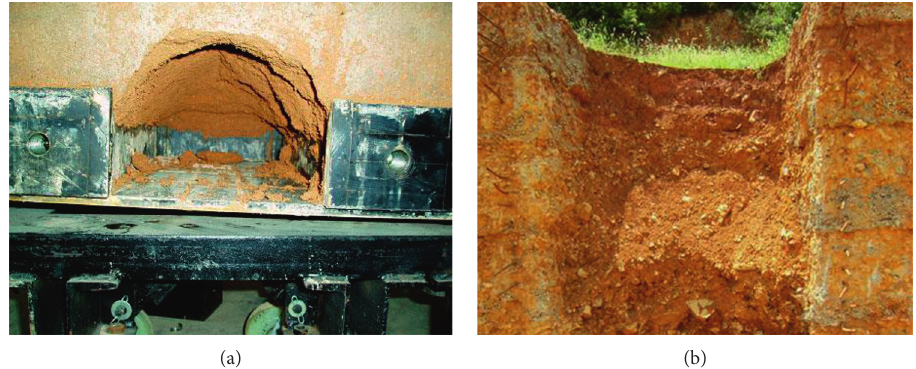
Figure 2: Pile-side soil arch destruction. (a) Laboratory test. (b) Practical